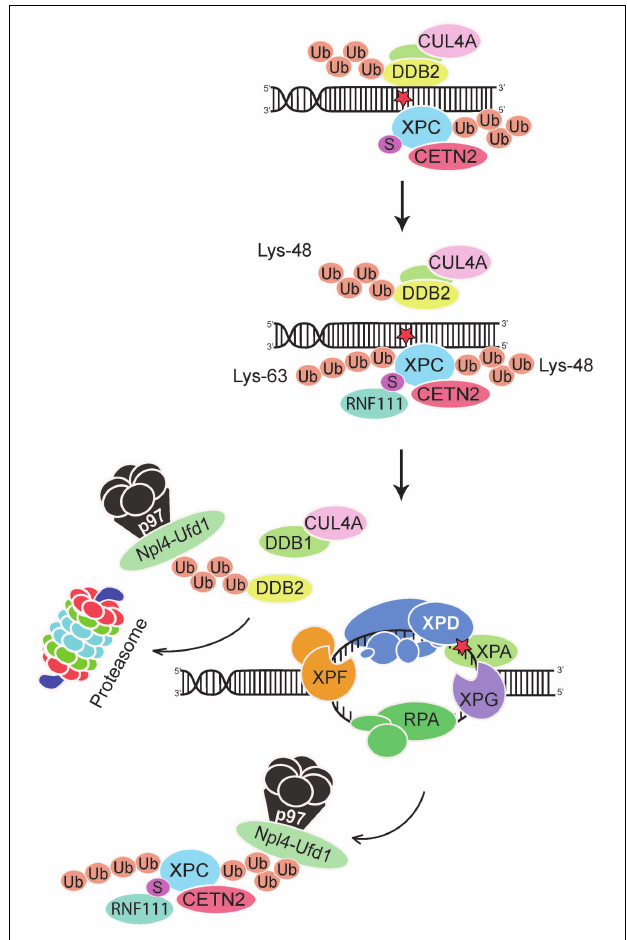
FIGURE 3 | Extraction of DDB2 and XPC from chromatin. The p97 segregase coordinates GG-NER activity by removing Lys48-ubiquitinated DDB2 and Lys48-ubiquitinated XPC from chromatin, thus promoting downstream recognition (by the XPD subunit of TFIIH in conjunction with XPA and RPA) and double DNA incision. The XPC subunit is thought to leave the preincision complex after recruitment of TFIIH but before engagement of the DNA endonucleases XPF-ERCC1 and XPG (Scharer, 2013; van Cuijk et al., 2015). Ubiquitinated DDB2 is forwarded to the proteasome for degradation, whereas XPC is recycled by de-ubiquitination (He et al., 2014; Lubin et al., 2014; Puumalainen et al., 2014). Lys63-linked ubiquitin chains on XPC may further enhance these dynamic relocations at UV lesions by favoring the dissociation of DDB2 from XPC. See text for further details on the postulated dual role of CRL4 DDB2 (generating Lys48-linked ubiquitin chains) and RNF111 (generating Lys63-linked ubiquitin chains) in regulating GG-NER activity. Npl4-Ufd1, adaptor complex that confers specificity to the p97 segregase; the UV radiation damage is symbolized by a red